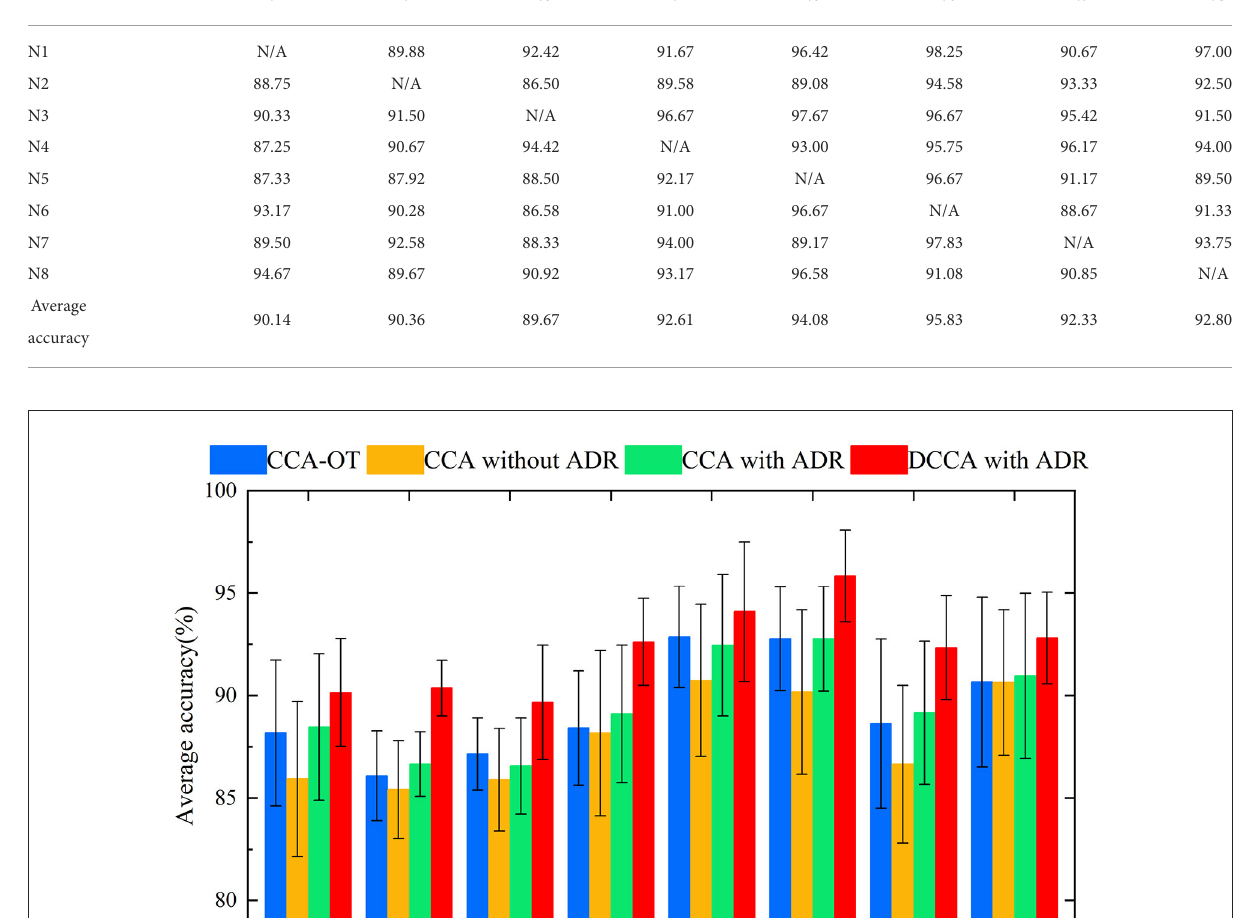
TABLE 4 Experimental results for user-independent DCCA-with-ADR framework. Training user